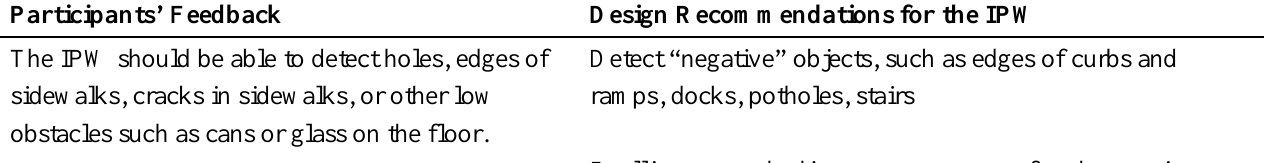
Table 3. Design recommendation examples for IPWs based on participants’